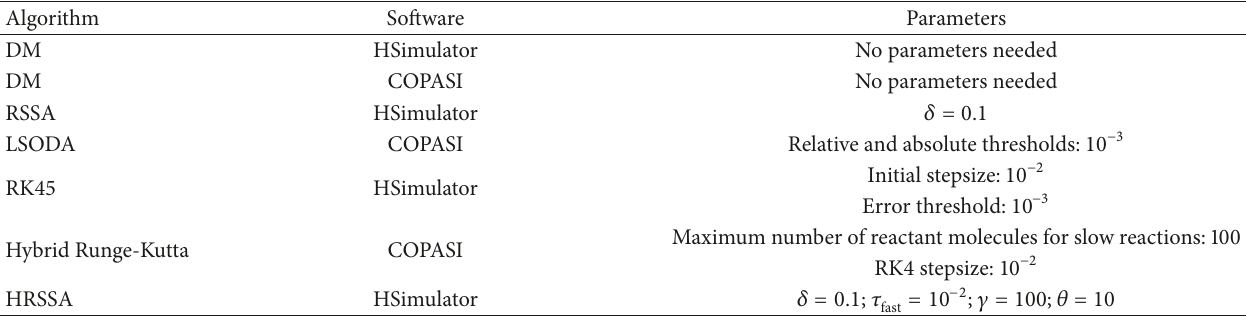
Figure 1: The HSimulator graphical user interface allows easily defining, even complex, biological models in terms of customary text-based reactions. The appropriate simulation strategy can be selected and parameterised as well according to the model, although the HRSSA method offers the best hybrid simulator. The figure shows the Oregonator model [8] simulated by the HRSSA algorithm [21]. The plot shows variable abundances in logarithmic scale to illustrate the switch between the deterministic simulation of fast reactions (high abundances) and the exact stochastic simulation of slow reactions (low abundances). Table 1: Simulation parameters used for the benchmarks of the compared